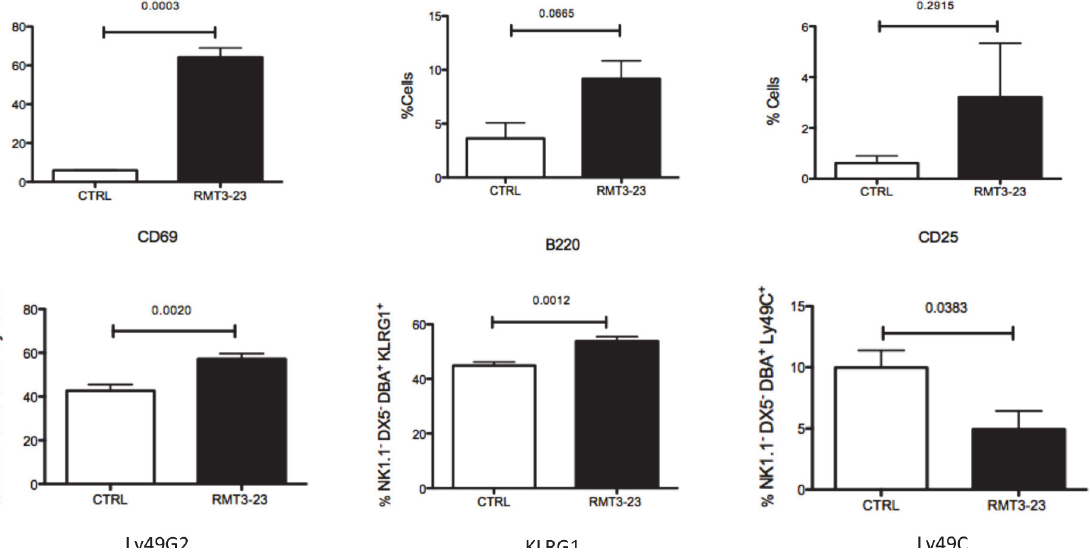
Fig 4. Effect of RMT3-23 treatment on expression of activation markers and inhibitory surface receptors on uNK cells. Treatment with RMT3-23 significantly upregulates the expression of CD69 on NK1.1 - DX5 - DBA + cell population. A similar trend of increased expression was also observed in case of B220 and CD25 levels after treatment with RMT3-23 although the data were not statistically significant. RMT3-23 treatment also significantly down regulates Ly49C expression and up regulates KLRG1 and Ly49G2 on NK1.1 - DX5 - DBA + cells. Data are presented as mean ± SEM and are representative of at least 3 experiments. Statistical analysis was done using unpaired t test.